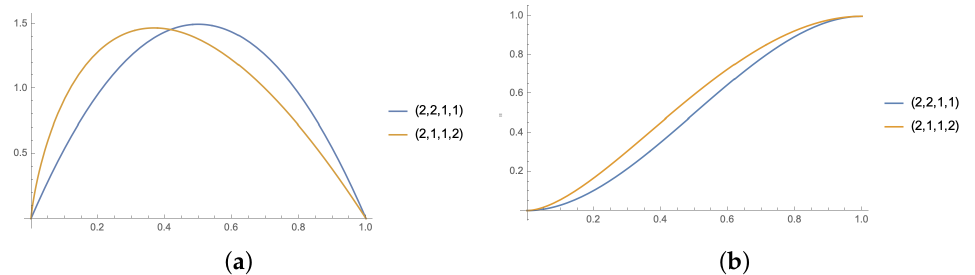
Figure 3. PDFs and CDFs of X 2,2,1,1 and X 2,1,1,2 . ( a ) f 2,2,1,1 and f 2,1,1,2 densities. ( b ) X 2,2,1,1 and X 2,1,1,2 distribution